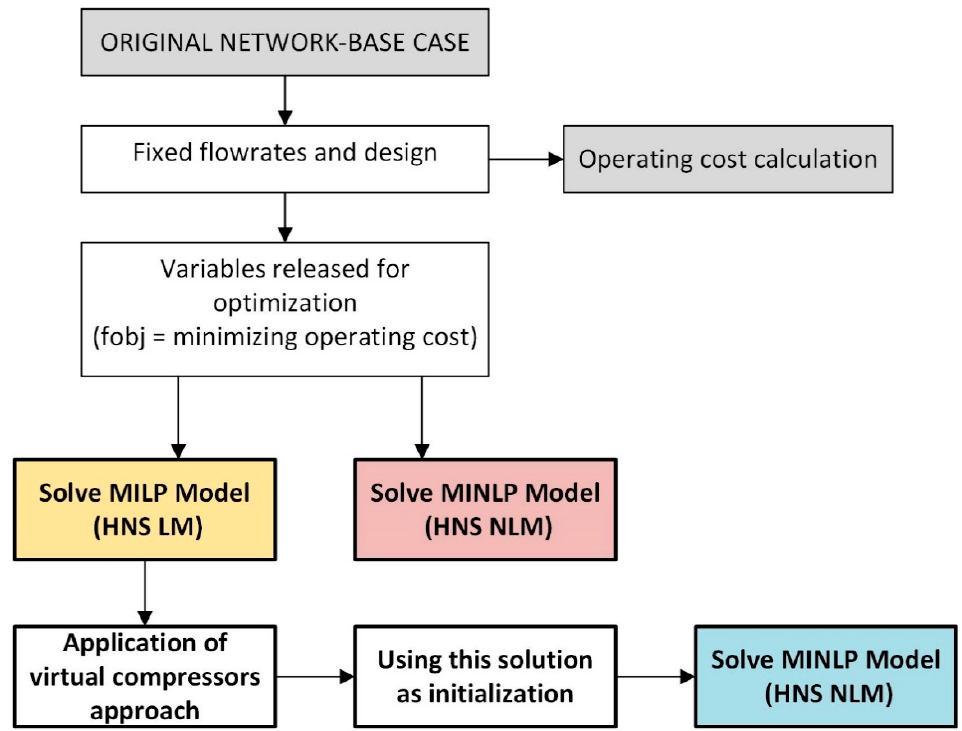
Figure 3. Summary of the methodology proposed in this article, through optimization via linear and nonlinear model.